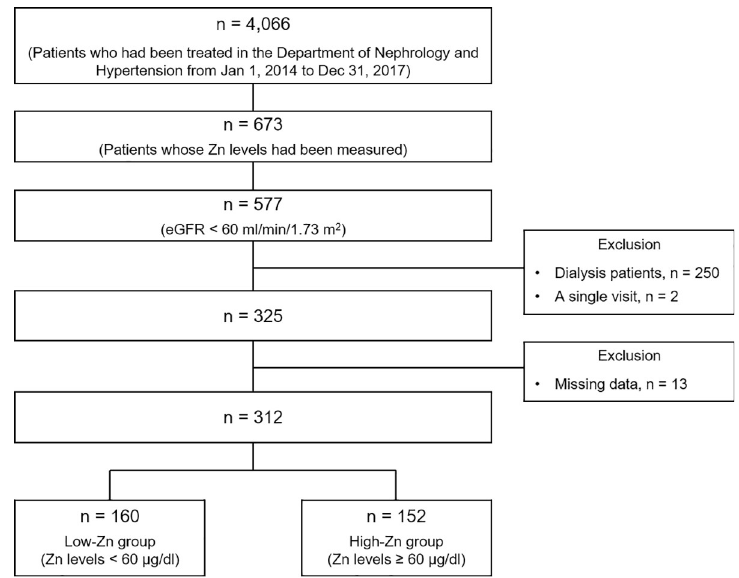
Fig 1. Flowchart of the study population. Of 4,066 patients, 312 were included in this study. The study patients were classified into two groups: those with Zn levels < 60 μ g/dl (low-Zn group) and those with Zn levels � 60 μ g/dl (high- Zn group). Abbreviation: Zn, serum